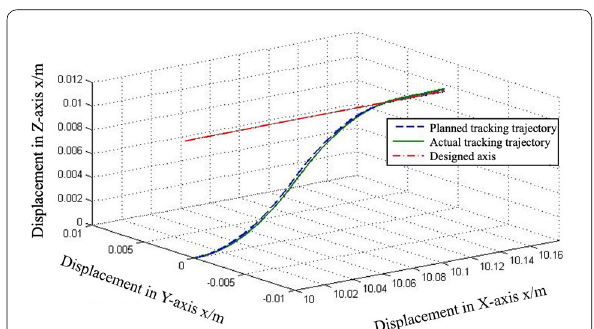
Figure 11 Tracking trajectory when deviation only in Z -axis